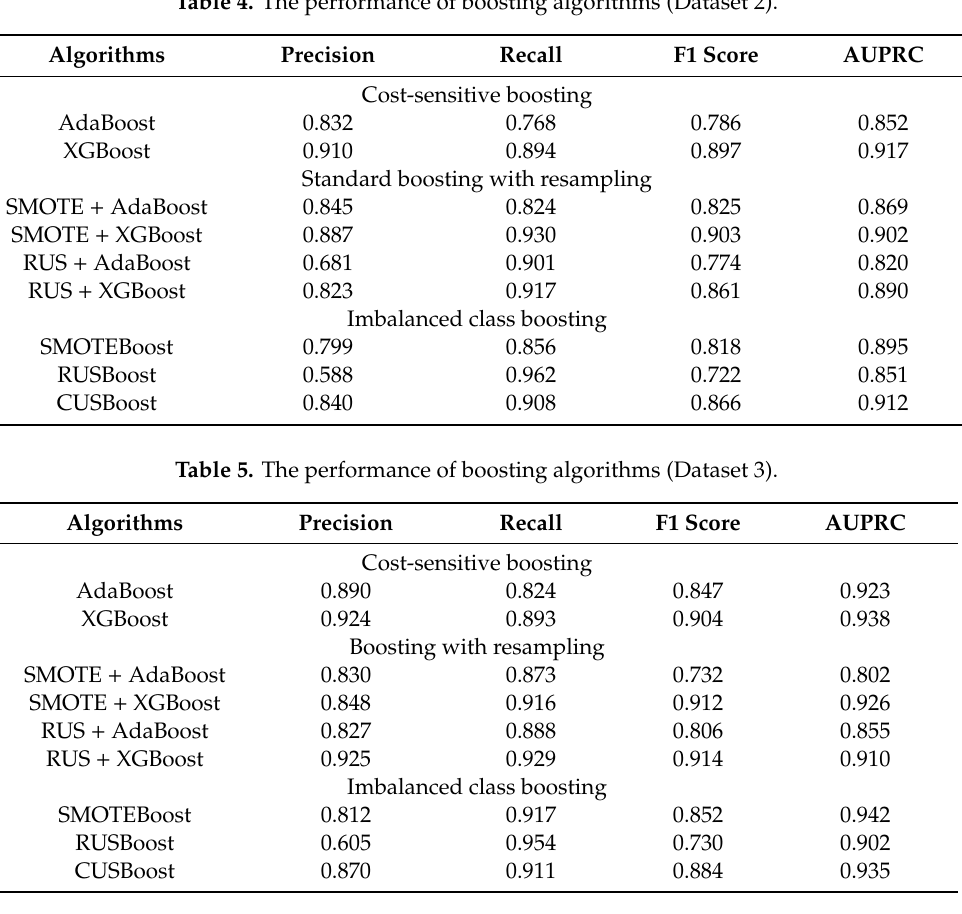
Table 4. The performance of boosting algorithms (Dataset 2).